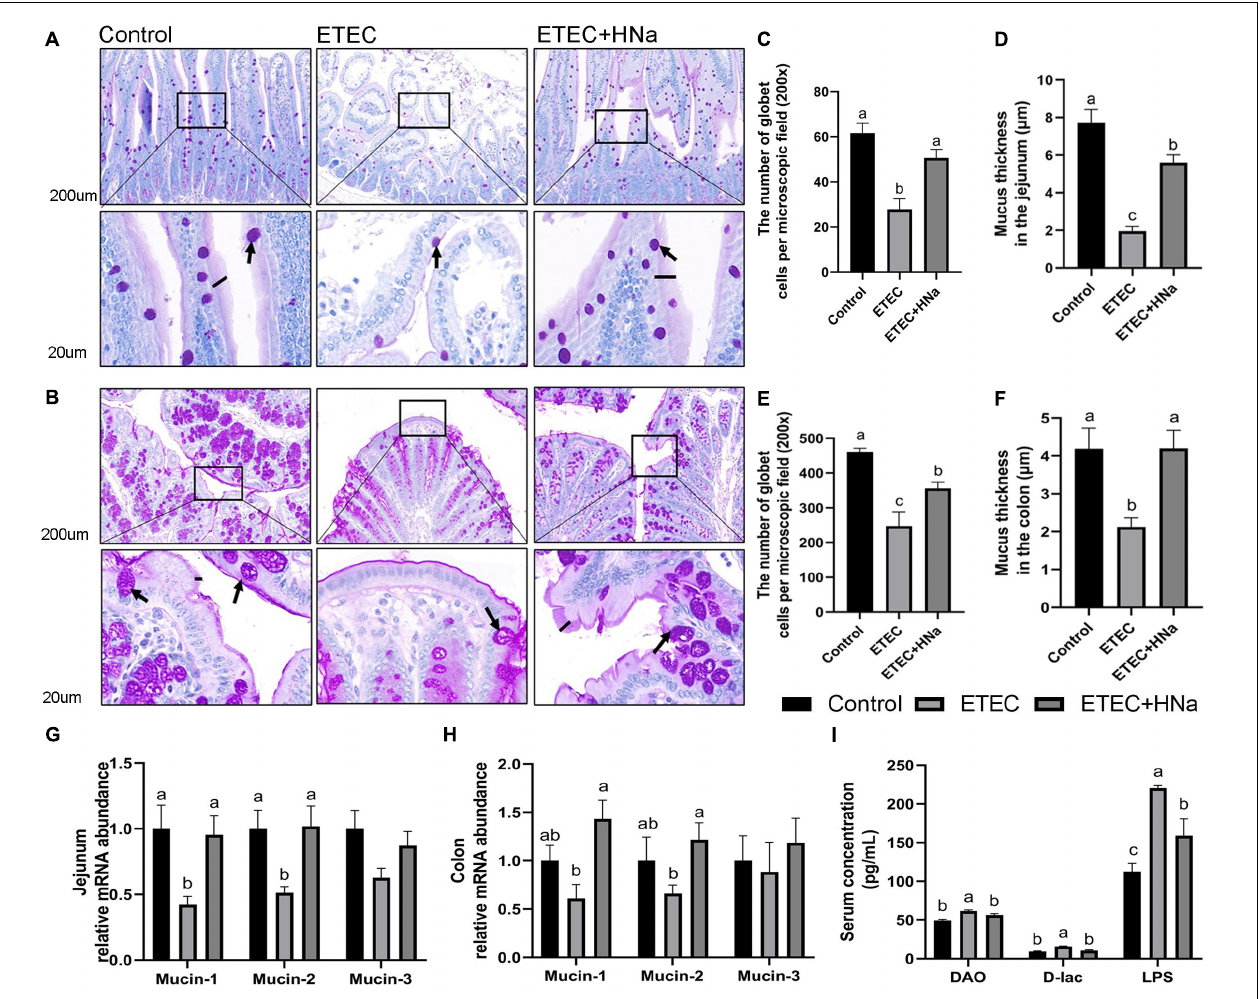
FIGURE 4 | Effects of sodium humate on the intestinal permeability in jejunum and colon of ETEC K88-infected mice. Representative images of the jejunum (A) and colon (B) stained with PAS (200 µ m). Arrow points to goblet cell; black bars indicate mucus layer thickness. The number of goblet cells per microscopic field and the mucus layer thickness in the jejunum (C,D) and colon (E,F) of mice. The relative mRNA expression of mucin-1, mucin-2, and mucin-3 in the jejunum (G) and colon (H) of mice. (I) The concentrations of serum DAO, D-lac, and LPS. All of the data are expressed as the mean ± SEM. Different superscript lowercase letters within each group indicate significantly different ( P <